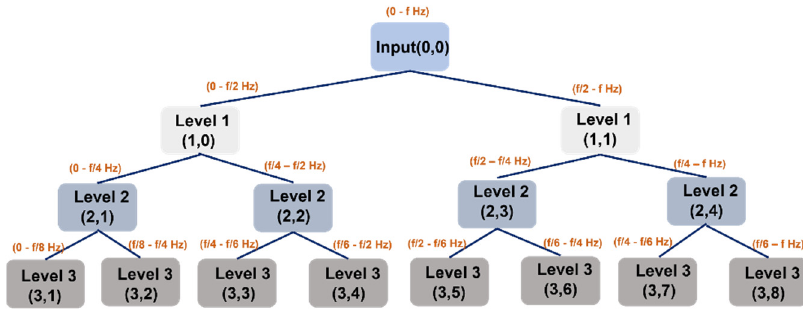
Figure 1. WPT decomposition tree up to 3 levels.